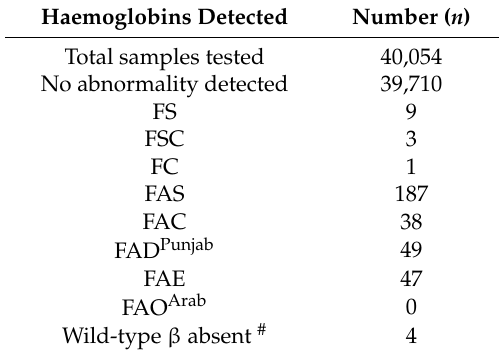
Table 1. Results of comparison of blood spots and the isoelectric focussing technique